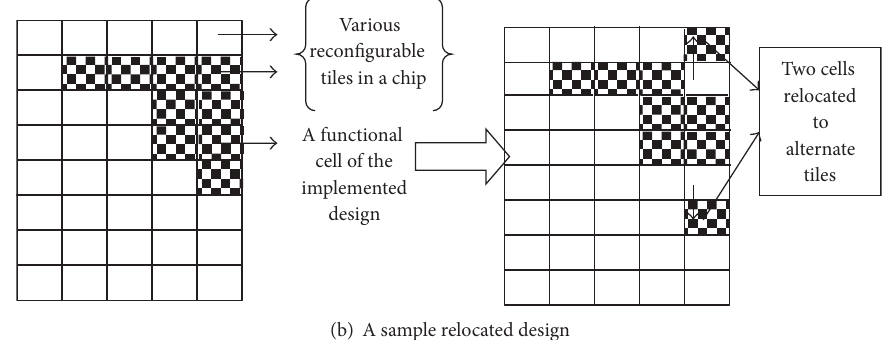
Figure 1: Generating various configurations by design